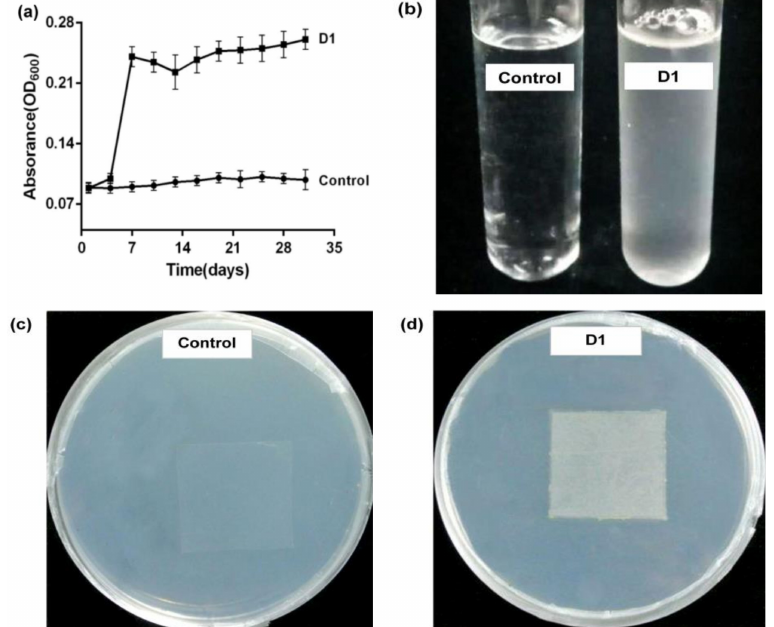
Figure 1. The growth of bacteria D1 in the medium in which a polyethylene (PE) film was the only carbon source. ( a ) The changes of optical density at 600 nm ( OD 600 ) during the 31-day cultivation. ( b ) Turbidity of the D1 bacteria solution. ( c ) Plate of control group containing PE film without D1. ( d ) D1 colonies grown around the PE film on the carbon-free source agar solid medium (APEM).